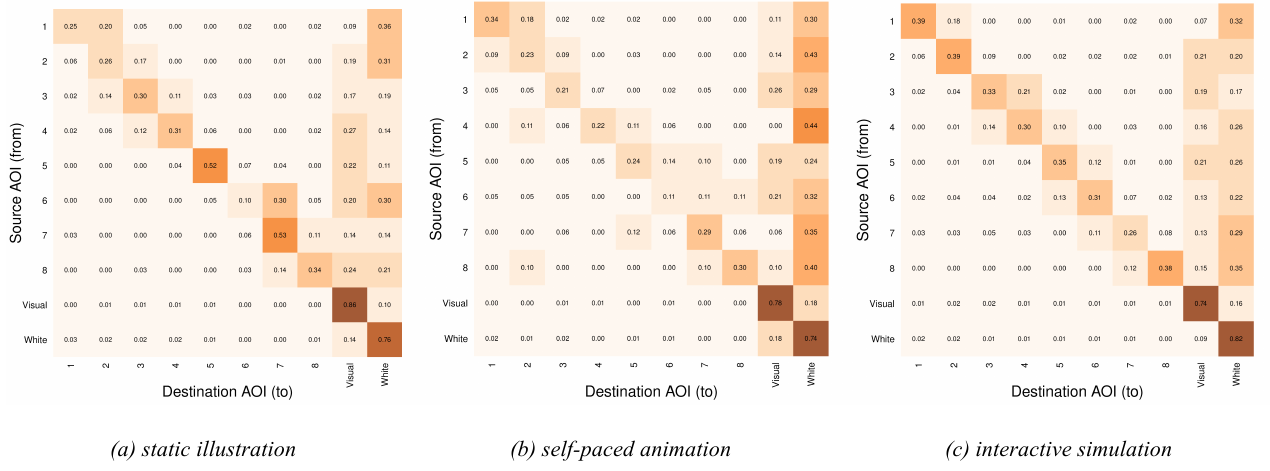
Figure 4. Fixation transitions. Digit labels (1–8) represent AOIs for each consecutive line of algorithm in the textual description. The label Visual refers to the AOI around the different visualization corresponding to the experimental condition, and the label White refers to the white space AOI (regions outside the textual algorithm description or the visualization AOI)